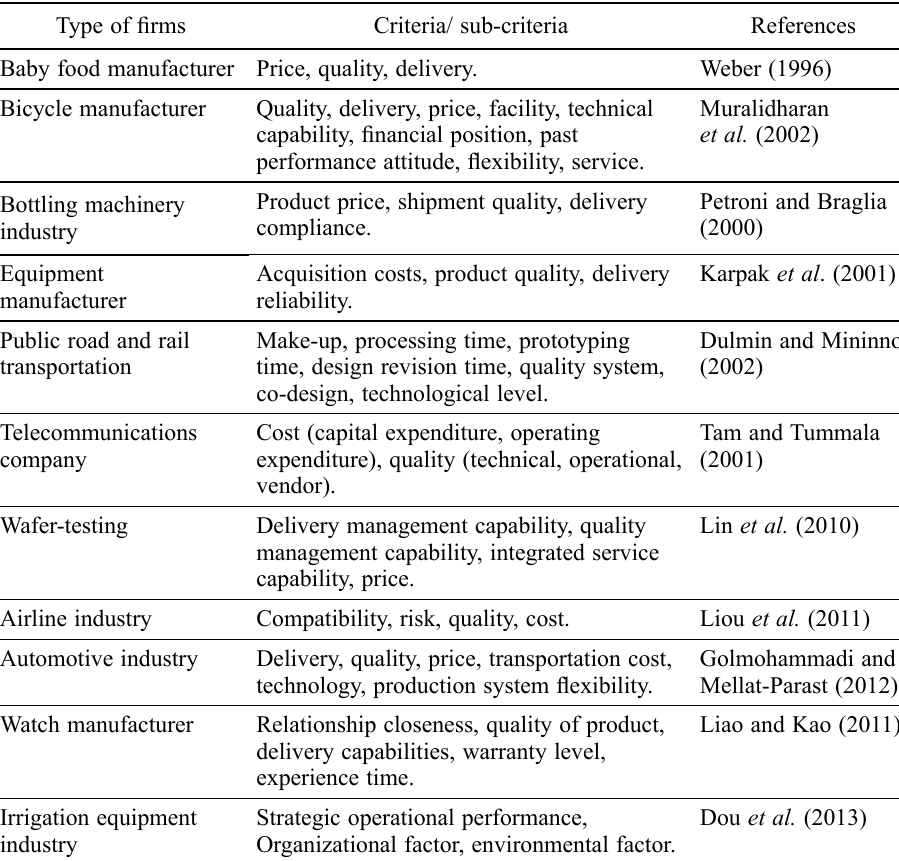
Table 1. Applications of selected criteria/ sub-criteria for vendor evaluation Type of firms Criteria/